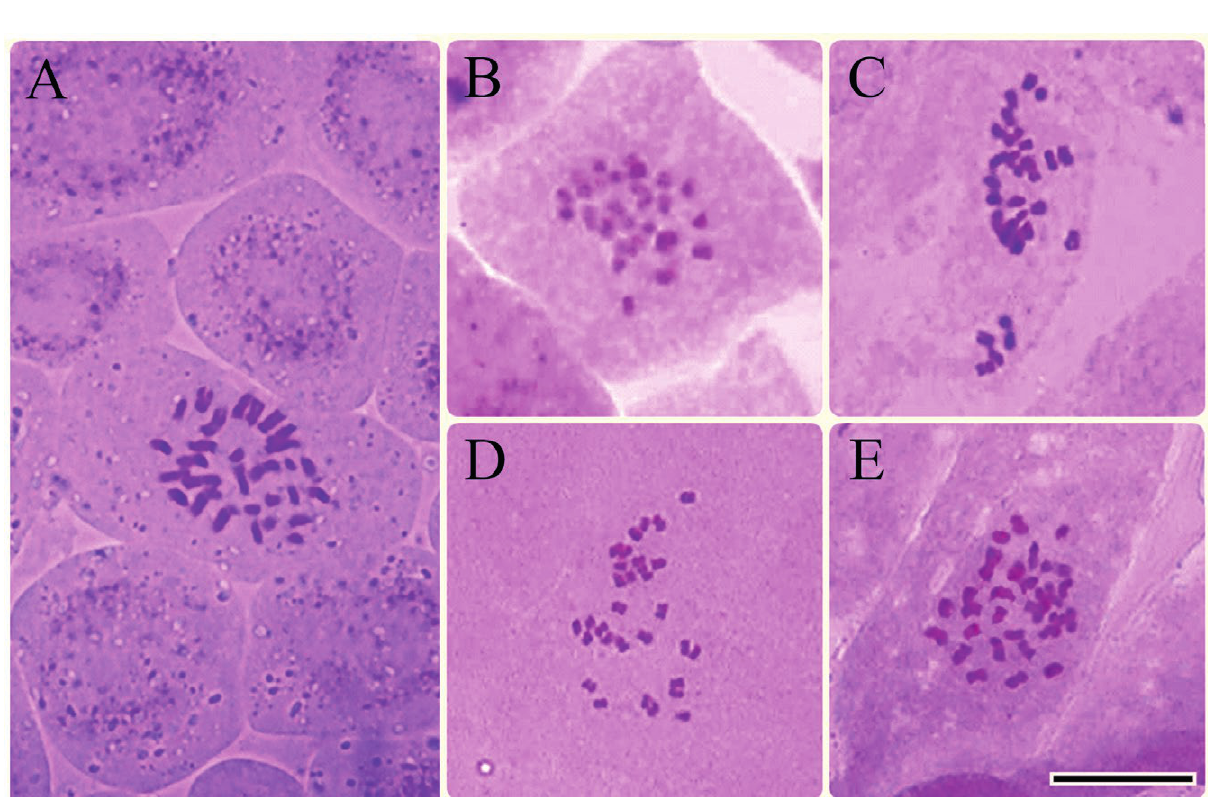
Figure 3. Metaphase chromosomes of Satureja species. (A) S. aintabensis ; (B) S. boissieri ; (C) S. icarica ; (D) S. macrantha ; and (E) S. spinosa . Scale bar 10 µm.